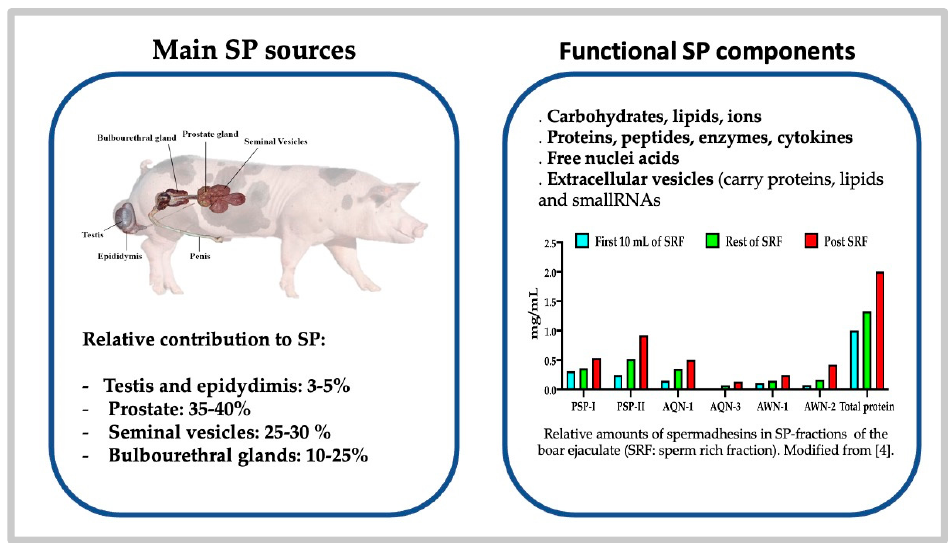
Figure 1. The sources, general functional components and variations in levels of the dominating protein, spermadhesins, along fractions of the ejaculated seminal plasma (SP) of pig, widely used by the authors as a biomedical research animal species.